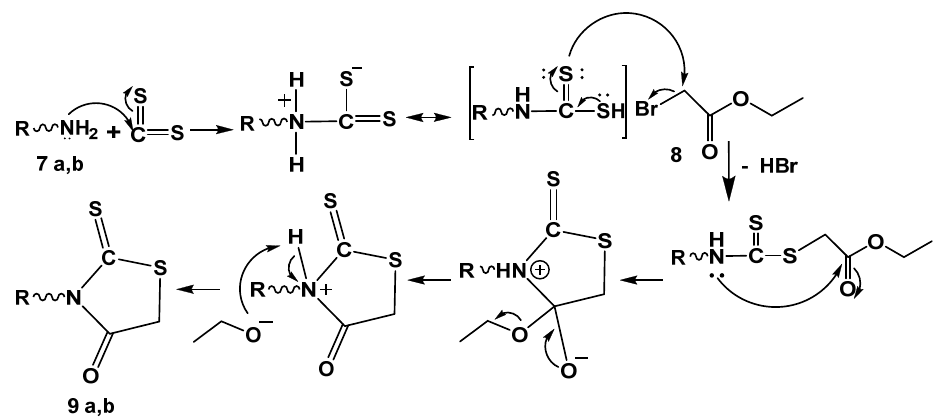
Scheme 8. Mechanism of rhodanine ring formation 9a , b . R = alkylene amino